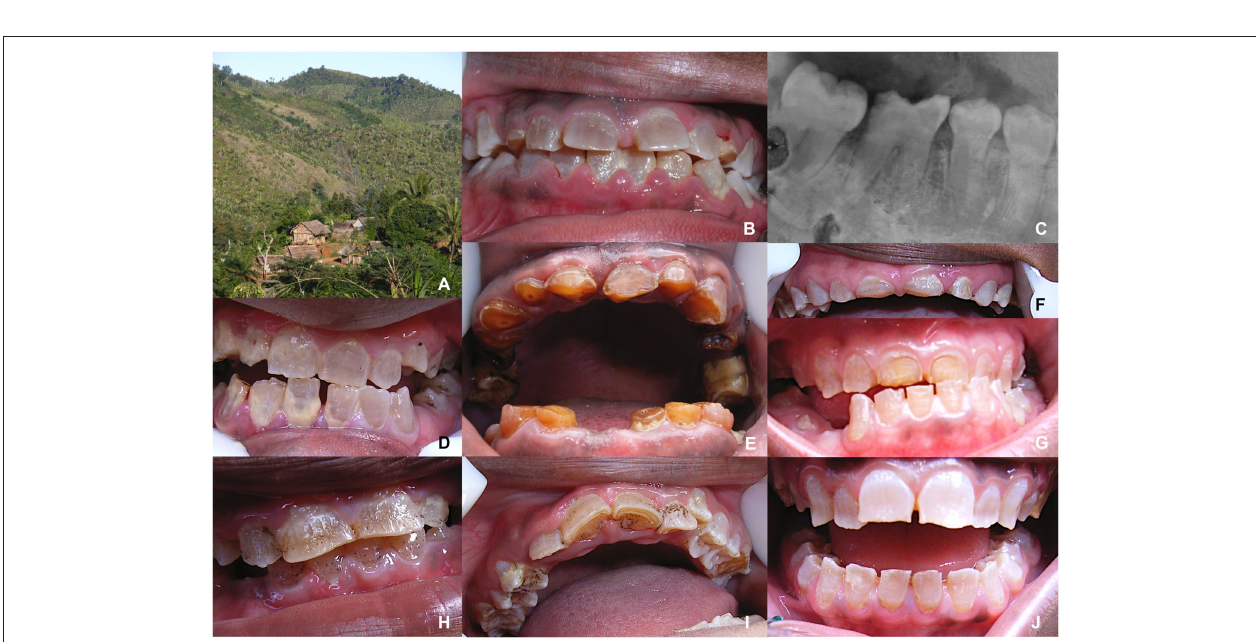
FIGURE 2 | Clinical description of the disease. (A) The remote village of Antananarivo. (B–J) Inhabitants’dentition showing the typical features of dentinogenesis imperfecta with the gray-brown discolouration of the dentin clearly visible after enamel cleavage and progressive tooth wear. (C) On the retro-alveolar radiography of the lower right premolar/molar sector of individual (B) , cervical constriction, short roots and the disappearance of pulp spaces due to erratic dentin formation represent the characteristic hallmarks of dentinogenesis imperfecta. (H–J) In addition to dentin anomalies, hypoplastic enamel defects exist, with the presence of pits, striae and flattened buccal